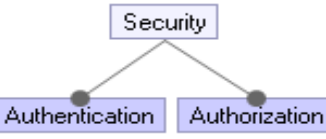
Figure 10. Feature diagram of